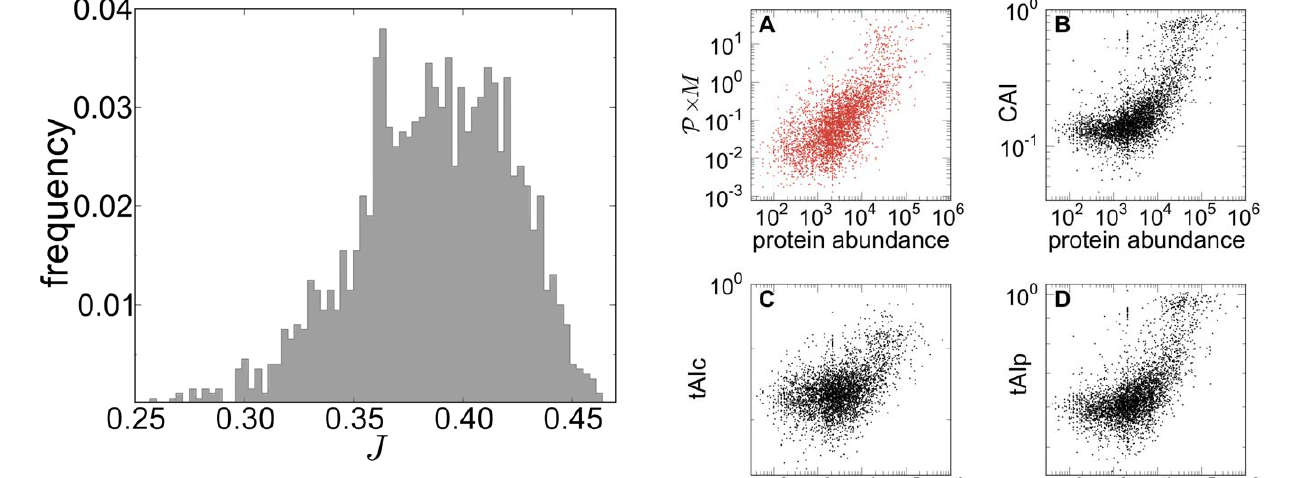
Figure 6. Normalised histogram of the simulated protein production rates of the YPL106C randomised ensemble. We constructed the randomised ensemble by shuffling the YPL106C codon choice at each sequence position, generating 2,000 different variants, each time keeping the amino acid sequence and overall codon composition constant. For example, for the chosen gene, CAI=0.521. The value of the chosen initiation is a ~ 10s { 1 .